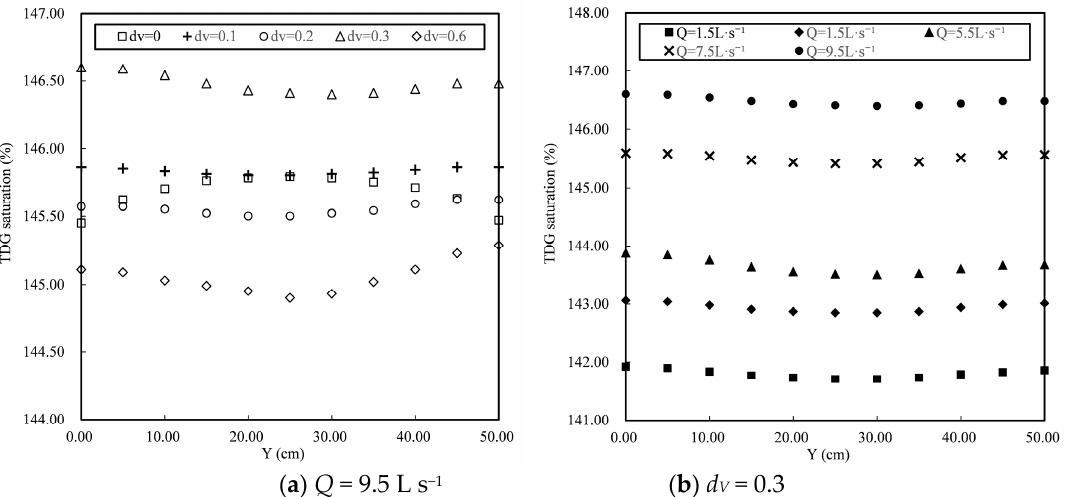
Figure 15. The lateral scattergram of supersaturated TDG.